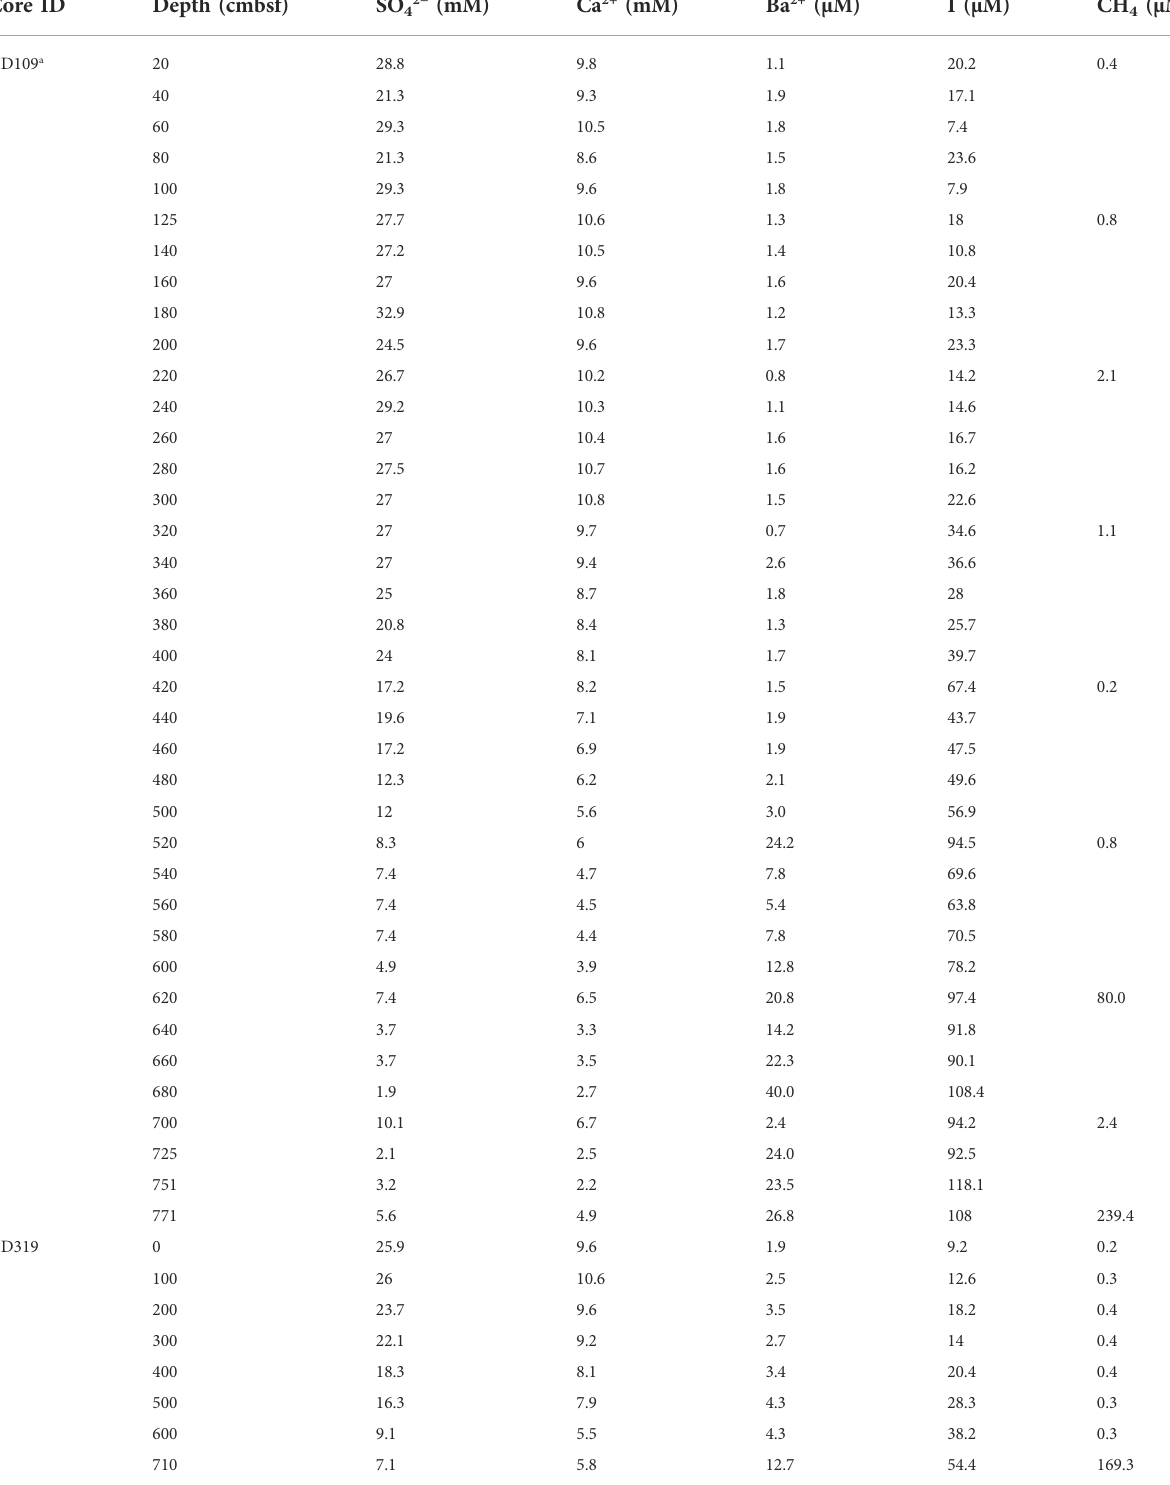
TABLE 5 Headspace CH 4 , porewater SO 4 2 − , Ca 2+ , Ba 2+ , I - concentrations of cores HD109 and